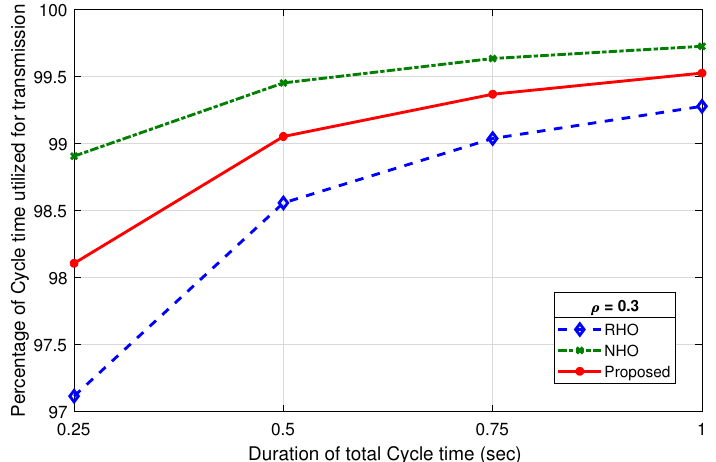
Figure 16. Percentage of cycle time utilization for data transmission against ρ =